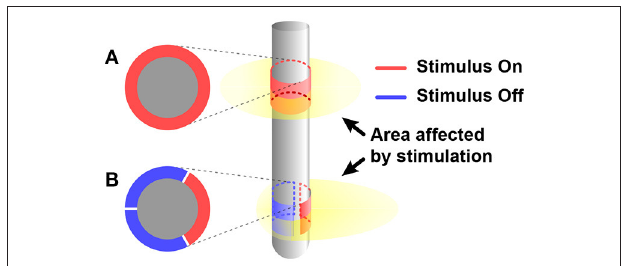
FIGURE 3 | Comparing affected area by electrical stimulus between when using (A) conventional ring shape electrode and (B) directional